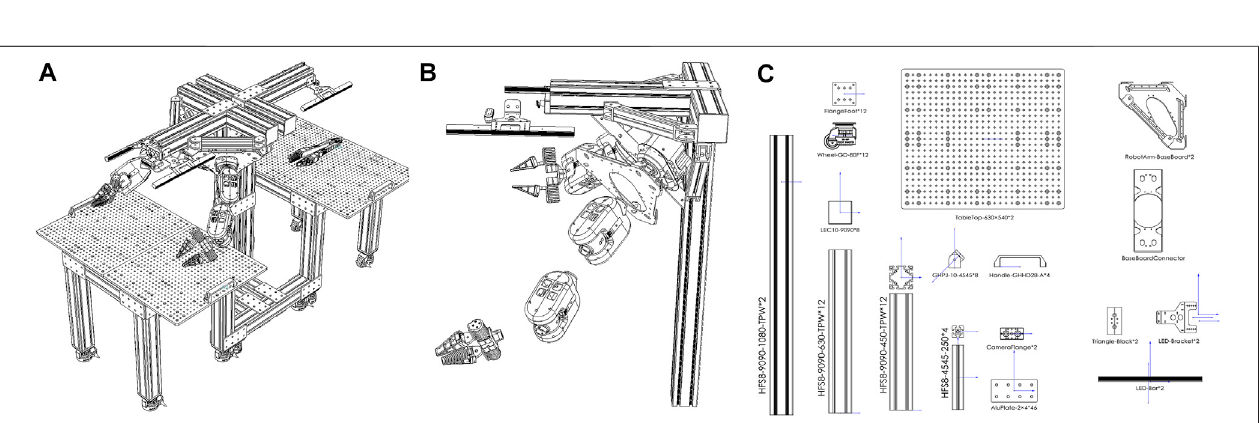
FIGURE 3 | DeepClaw2.0 Station: (A) 3D view, (B) robot arm explosion view, (C) details about components for data collection.